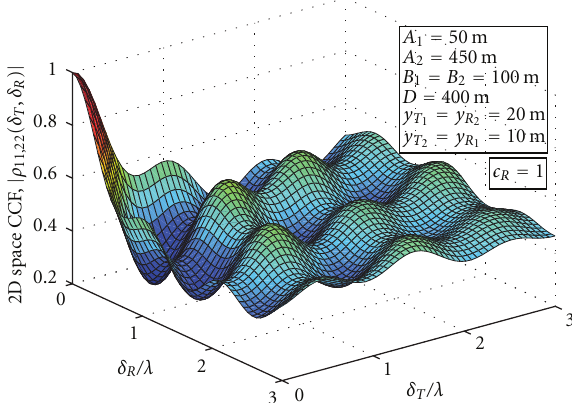
Figure 4: Absolute value of the 2D space CCF | ρ 11,22 ( δ T , δ R ) | of the reference model for a LOS propagation scenario ( c R = 1).